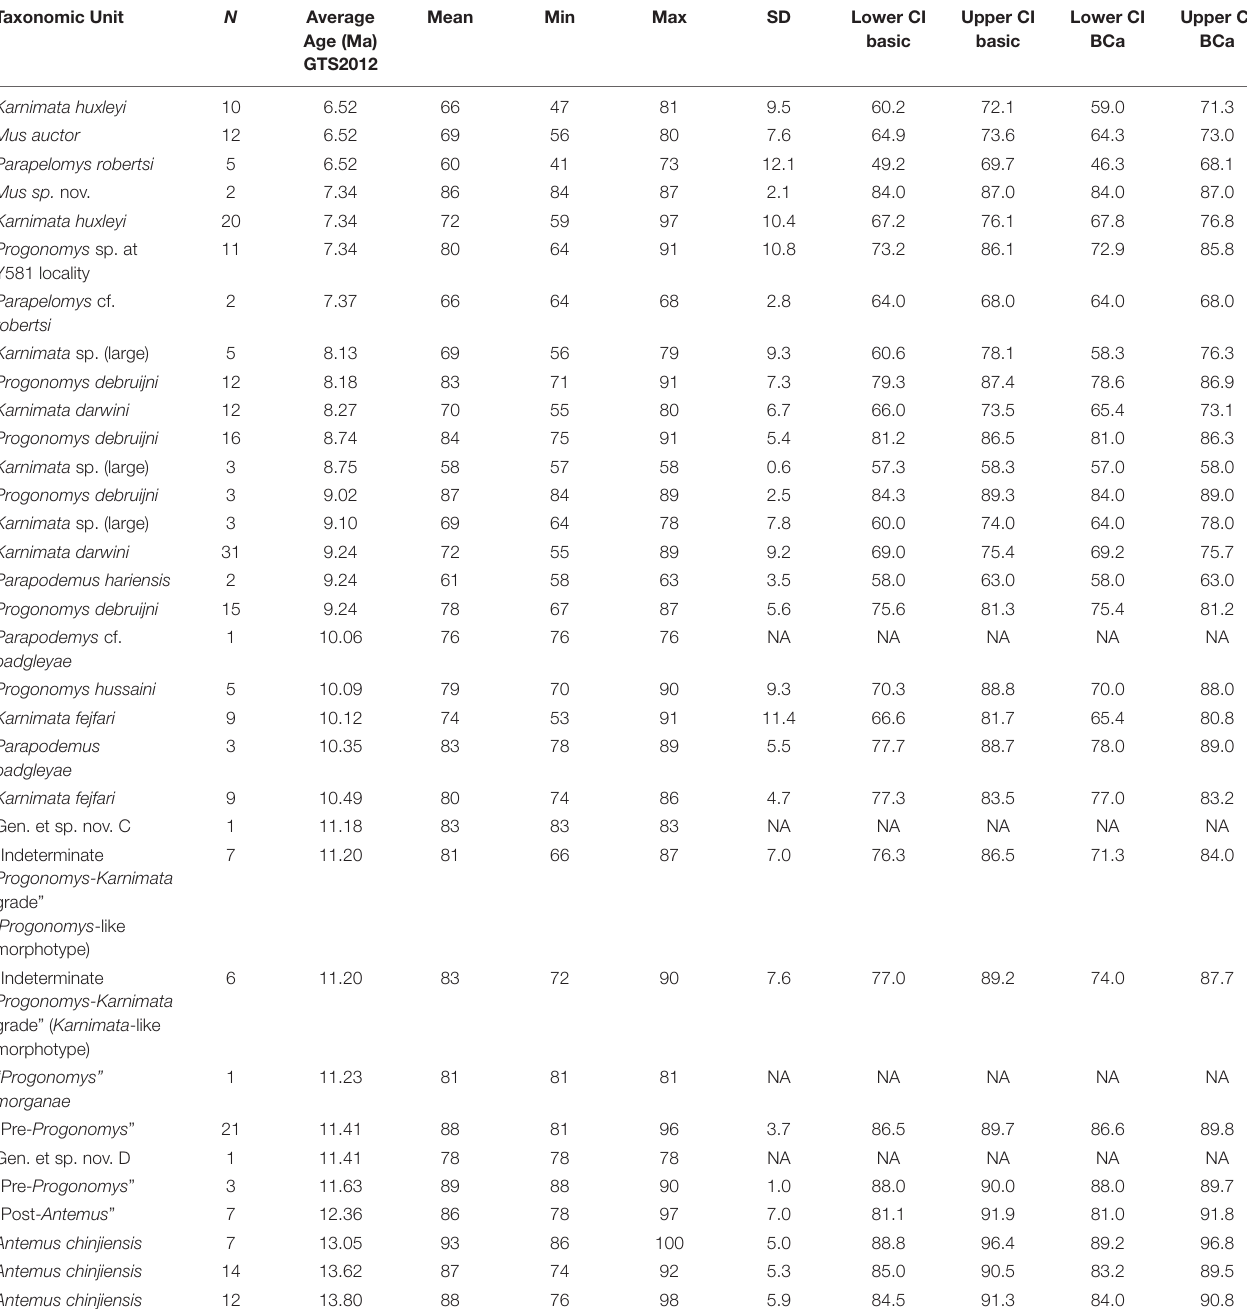
TABLE 5 | Summary statistics for axis angle through metacone in Siwalik murine rodents, corresponding to Figure 3D . Taxonomic Unit N Average